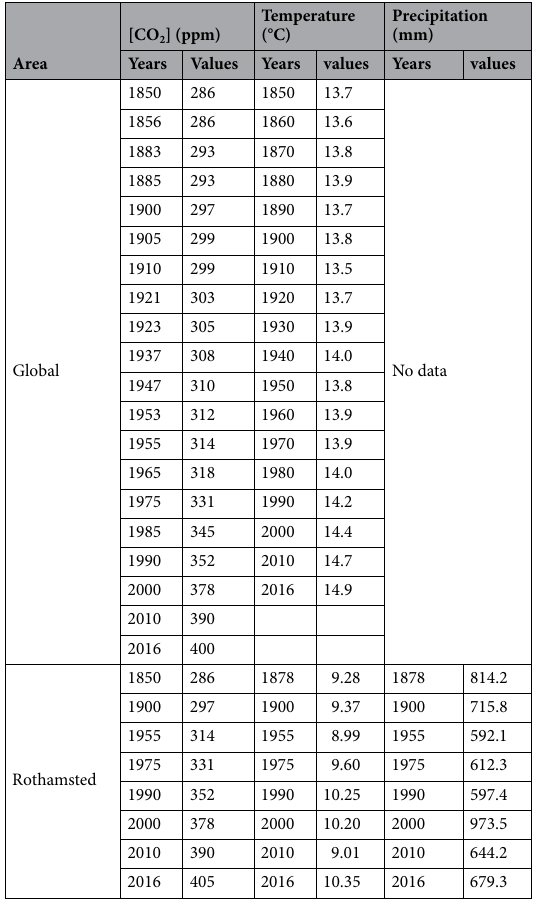
Table 2. Average environmental data recorded from 1850 to